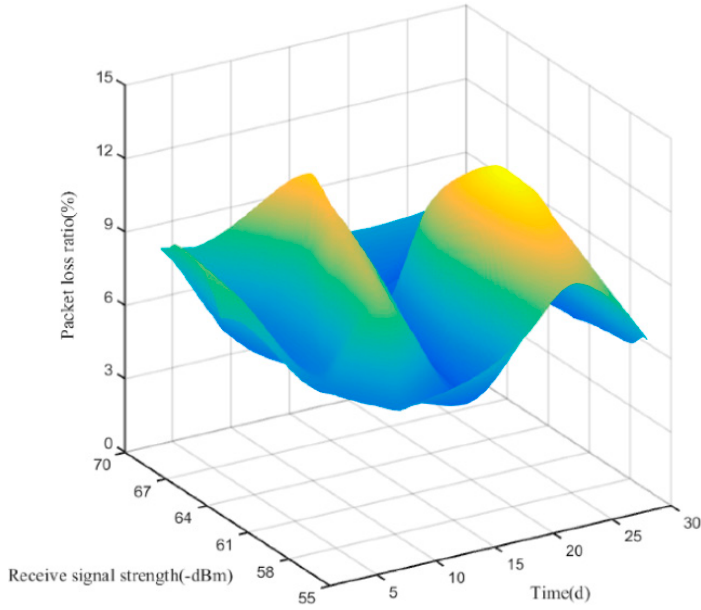
Figure 14. Communication link reliability based on LoRa and GPRS.